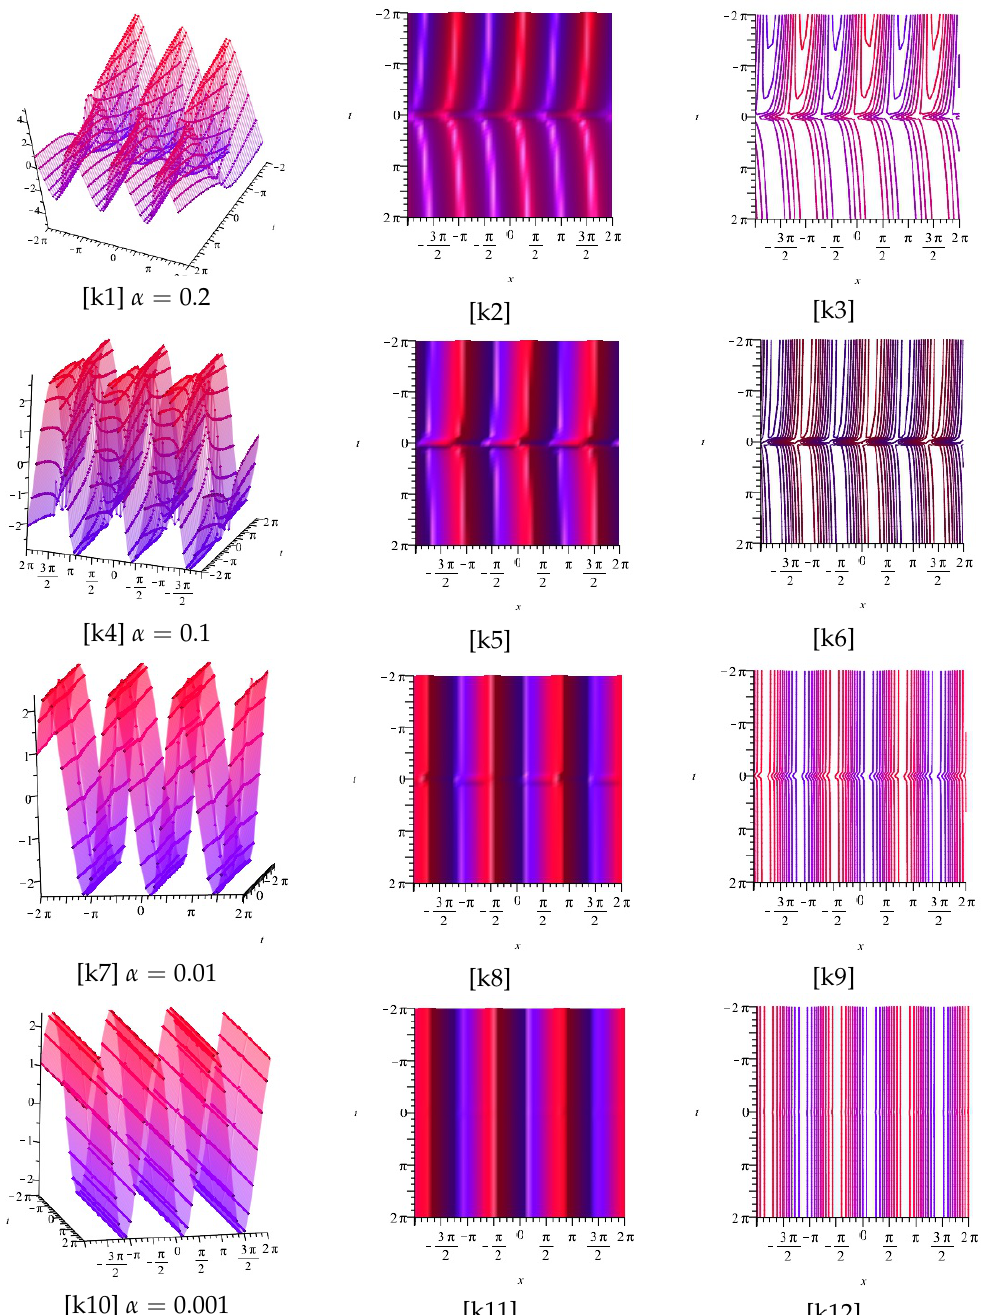
Figure 11. Now, [k1], [k4], [k7], and [k10] display the plots of the imaginary part of Equation (34), for λη > 0, and [k2], [k5], [k8], and [k11], as well as [k3], [k6], [k9], and [k12], display the z -axis orientation and the contour plot,